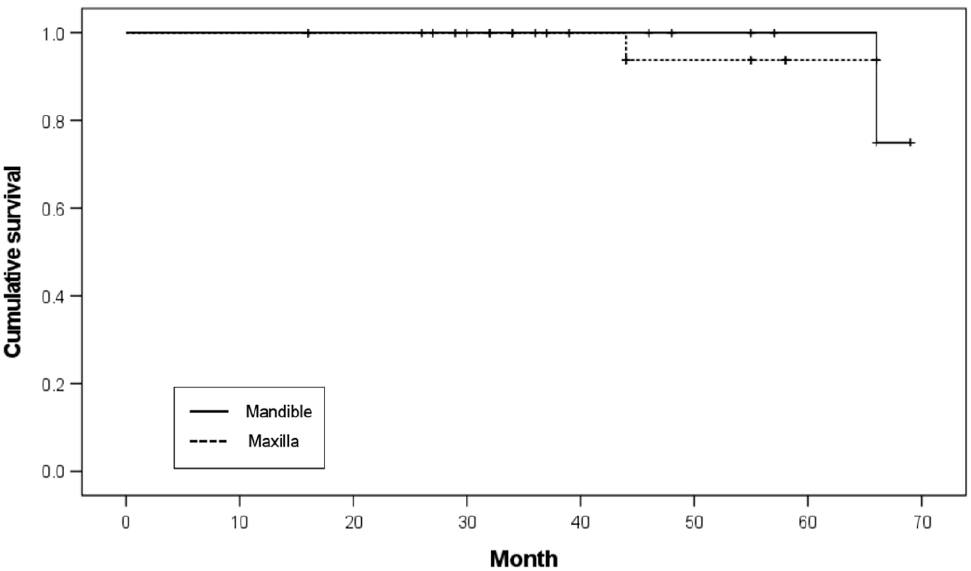
Figure 4. Kaplan–Meier survival curve according to restored arch.